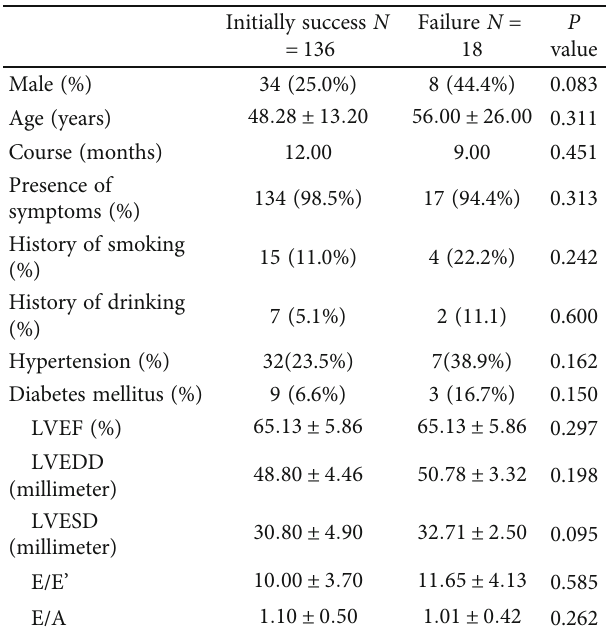
Table 1: Comparison of clinical characteristics in patients with initially successful and failed RFCA ( N = 154